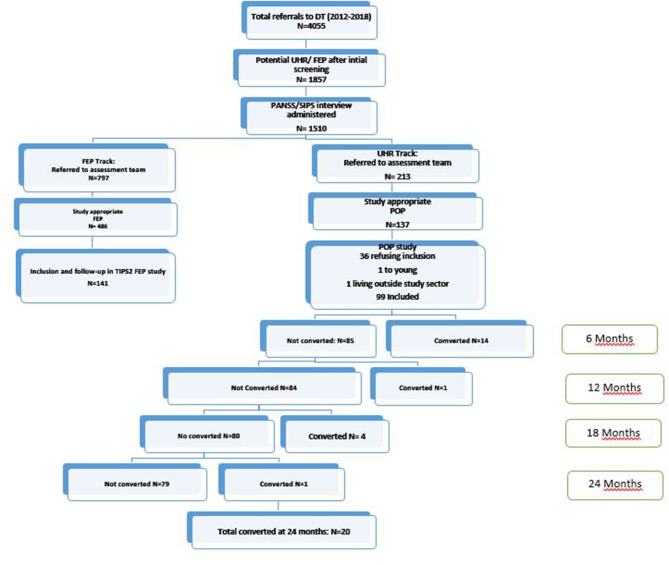
Study flow chart and psychosis conversions over time. DT, Detection team, FEP, first episode psychosis, UHR, ultra high risk, POP, prevention of psychosis; TIPS, early intervention for psychosis study; PANSS, positive and negative syndrome scale; SIPS, structural interview for prodromal syndromes.